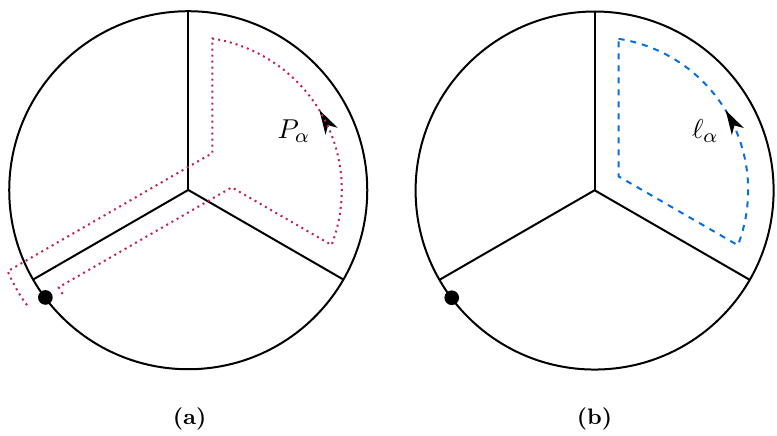
Figure 9. We distinguish between closed paths P (cid:11) in the graph ((cid:12)gure 9a) and the corresponding loops ‘ (cid:11) ((cid:12)gure 9b), which are equivalence classes of closed paths de(cid:12)ned modulo conjugation, and which are independent of the base point.